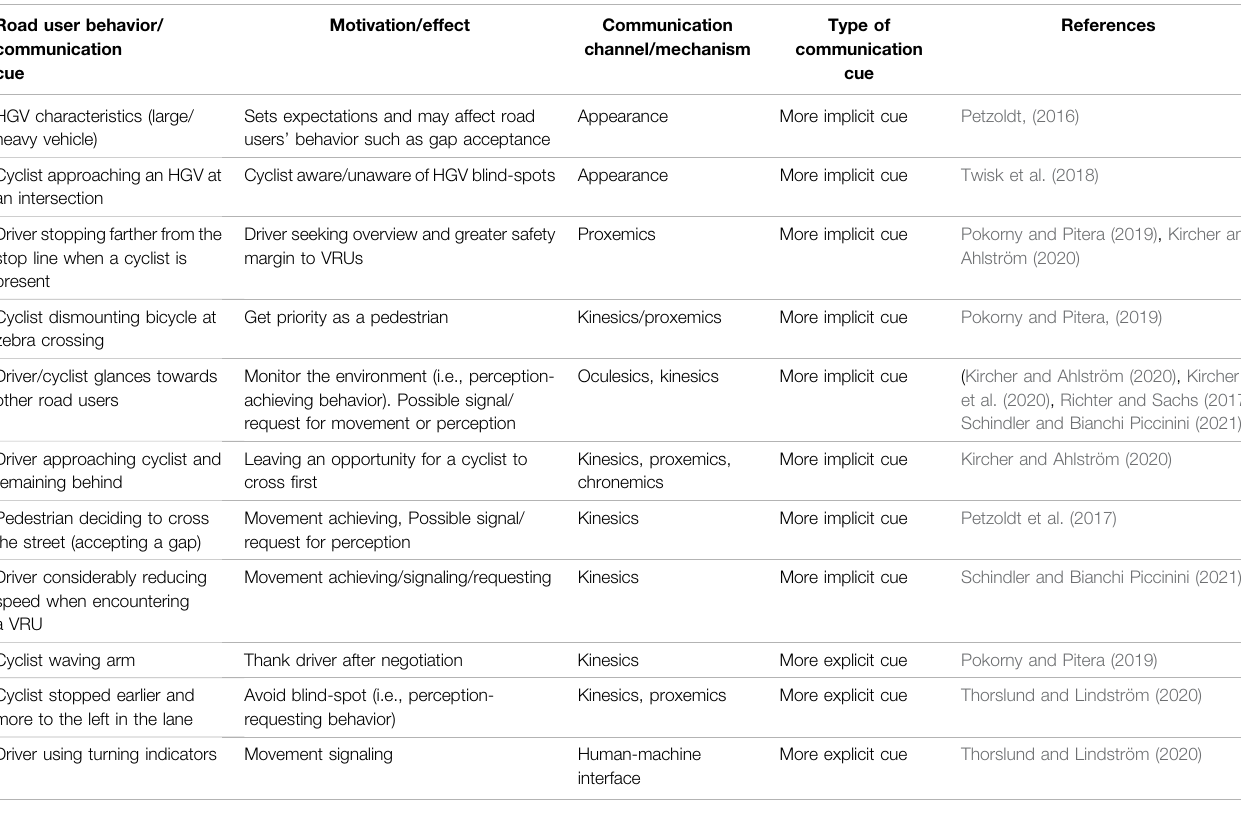
TABLE 4 | Reported interactive road user behaviors/communication cues from HGV-VRU crossing paths scenarios, including their motivation/effect, communication channel/mechanisms, type of cue, and references. Road user behavior/ communication